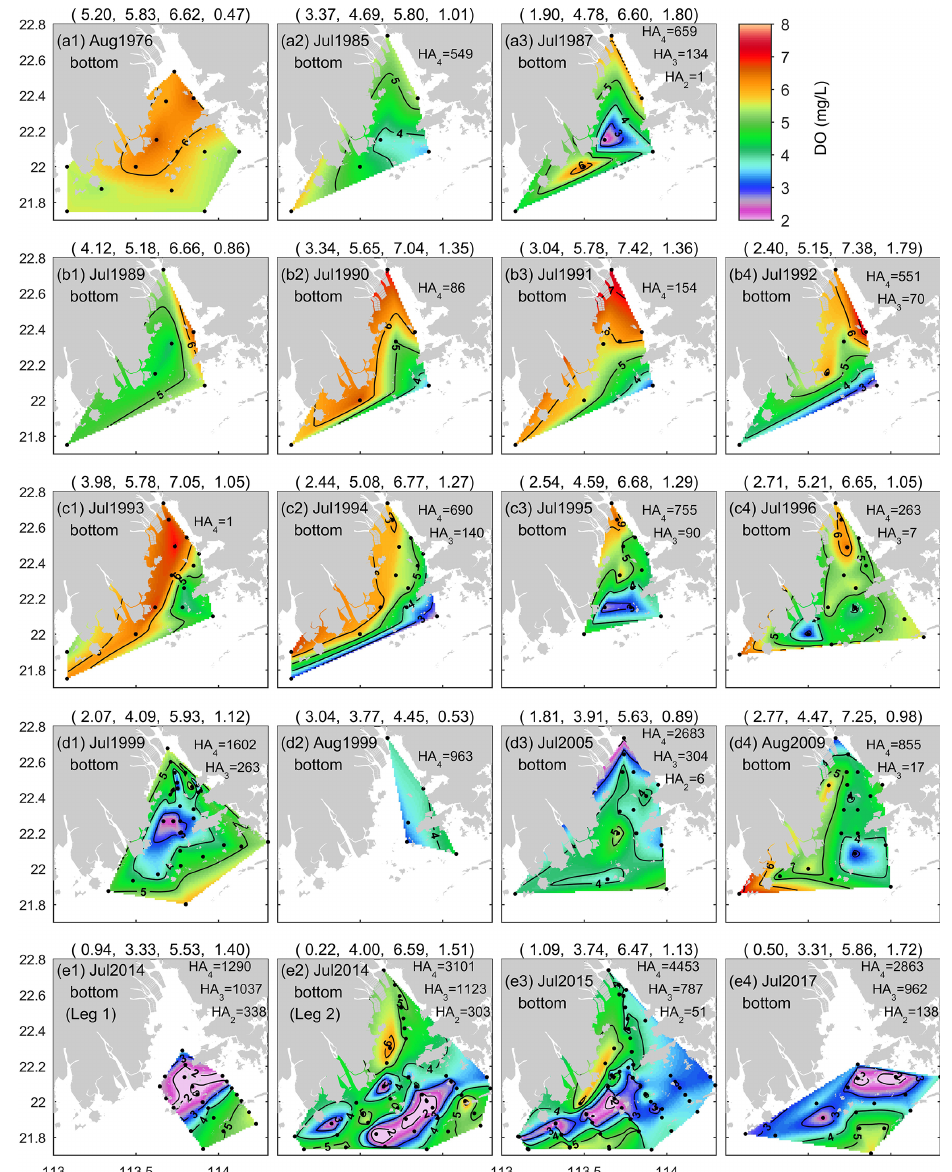
Figure 6. DO distributions at the bottom of the PRE for the summer months of 1976–2017. Due to the influence of Typhoon Rammasun, the cruise in July 2014 was divided into two legs, including (e1) Leg 1 on 13–16 July and (e2) Leg 2 on 19–27 July (Su et al., 2017). Note that HA 4 , HA 3 , and HA 2 represent the observation-based estimates of the areal extent (km 2 ) with DO < 4, DO < 3, and DO < 2mgL − 1 ,